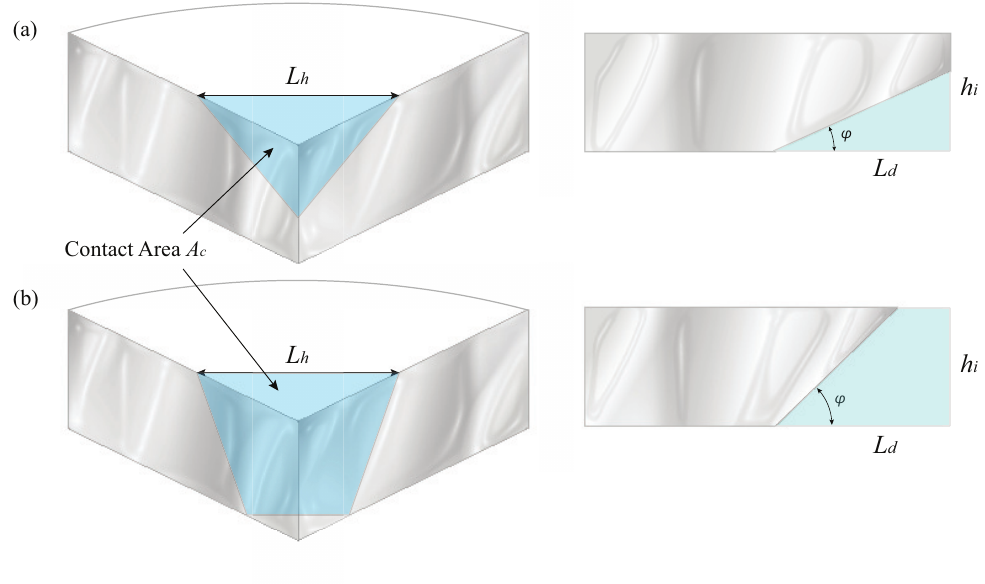
Figure 11. Contact area representation for two different ( a ) L d tan ( ϕ ) ≤ h i and, ( b ) L d tan ( ϕ ) > h i